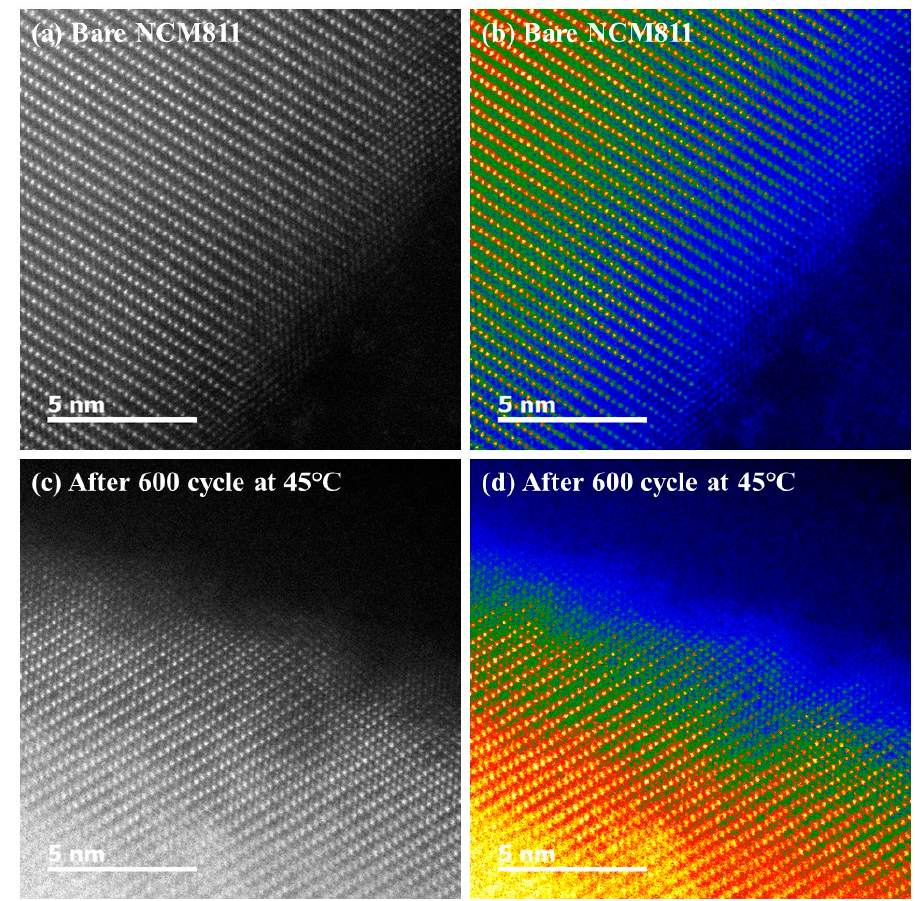
Figure 6. STEM images of the NCM811 surfaces: bare NCM811 ( a , b ) and after 600 cycles at 45 ◦ C ( c , d ). ( a ) and ( c ) are the original STEM images, and ( b ) and ( d ) are converted from gray scale into color using Digital Micrograph.